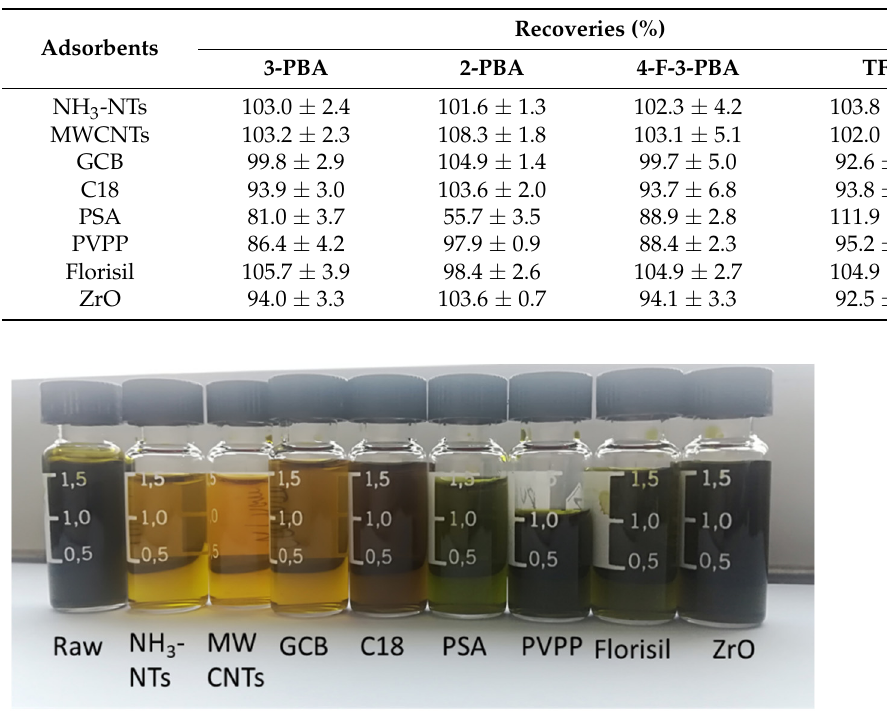
Figure 4. Tea extracts before (Raw) and after clean up by NH3-NTs, MWCNTS, GCB, C18, PSA, PVPP, florisil, and ZrO.